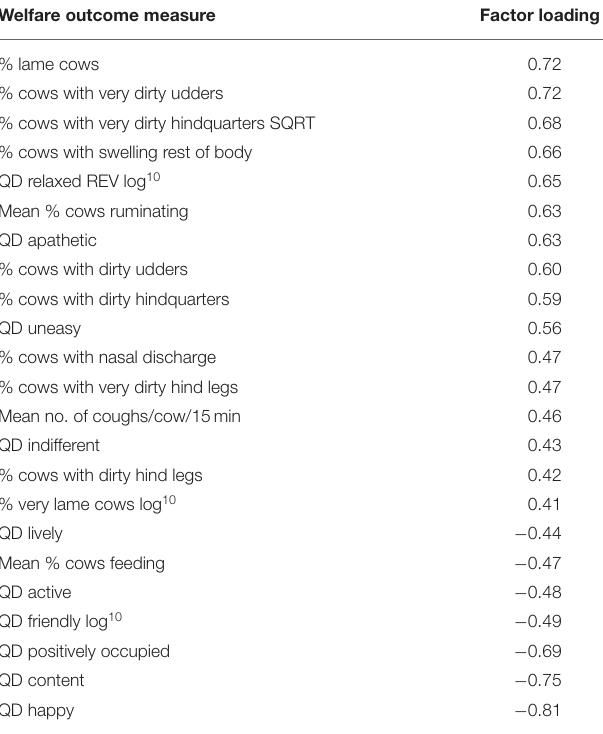
TABLE 4 | Simple linear regression model results of the significant relationships between the individual welfare outcome measures and their respective composite welfare